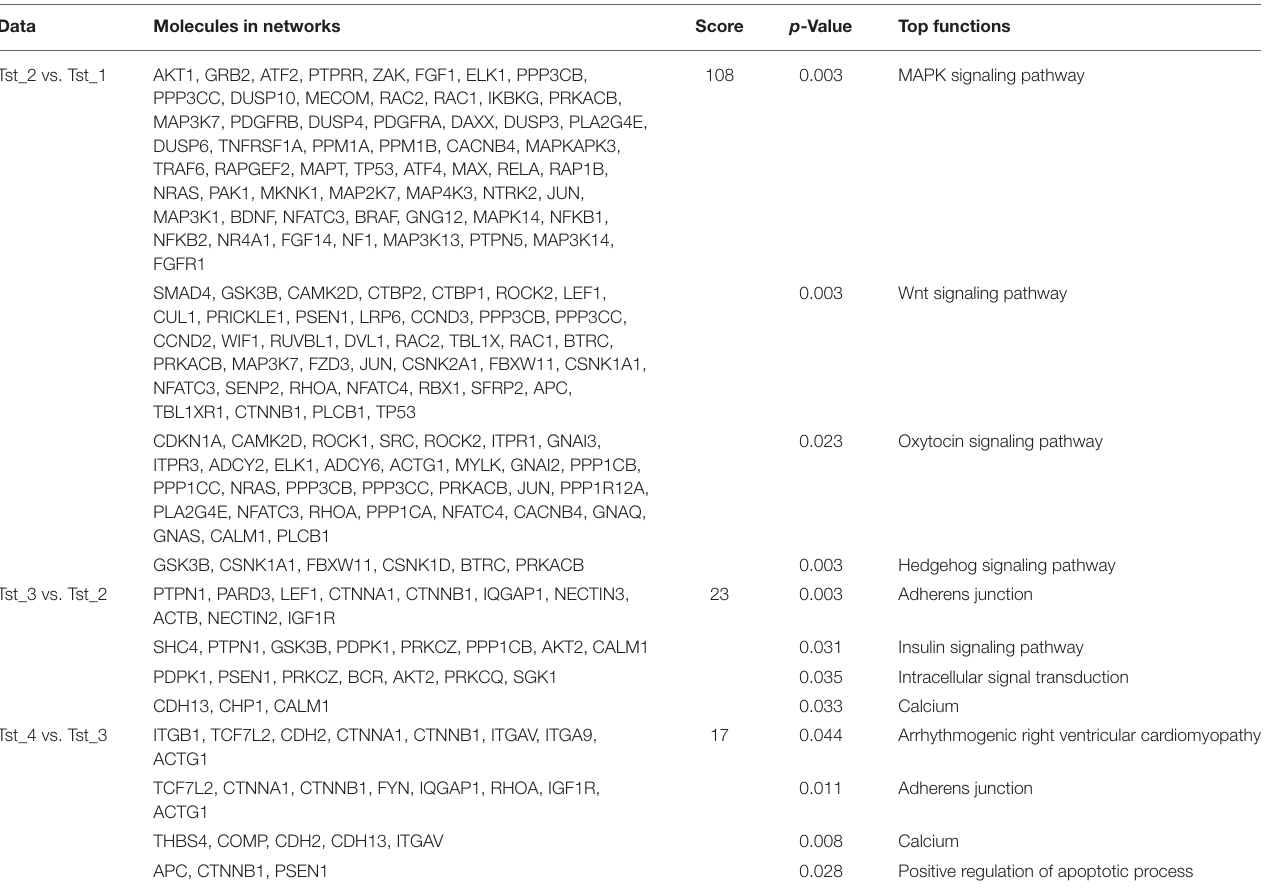
TABLE 1 | Summary of the represented networks generated by pathway analysis.